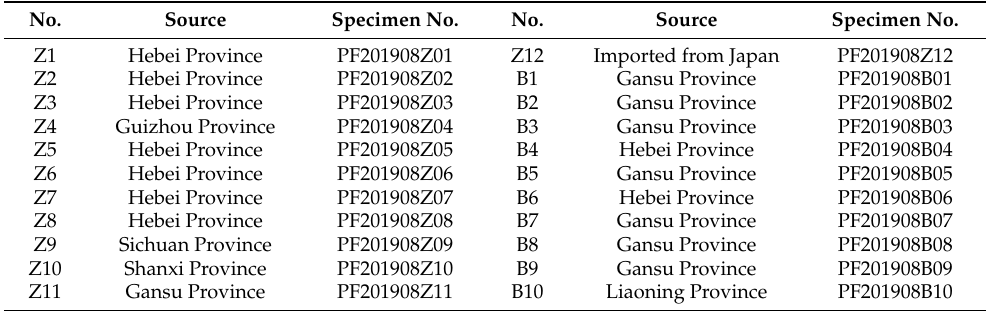
Table 1. The information of collected purple Perillae Folium (Z1–Z12) and green Perillae Folium (B1–B10).